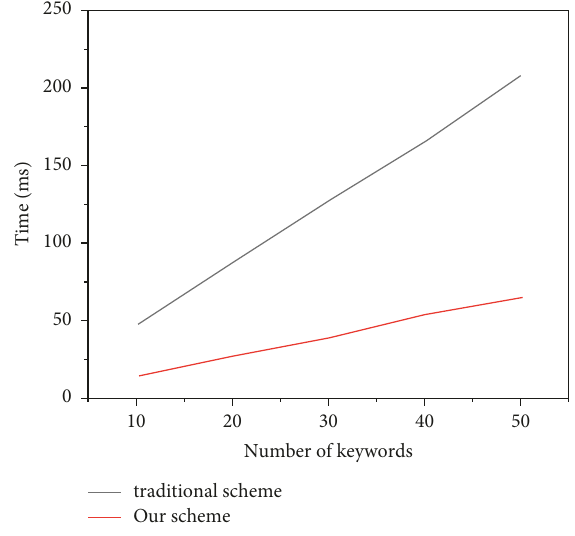
Figure 8: Time of encryption